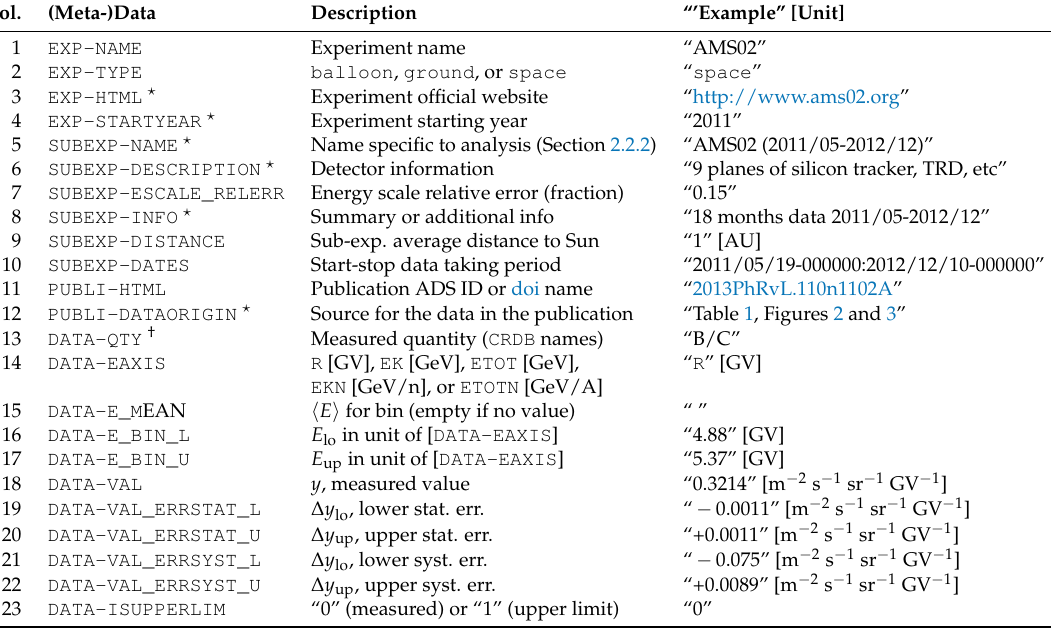
Table 2. Description of the 23 expected columns in the csv file prepared by the user to submit data. The table shows the column ID, the associated keyword in the database structure (see Figure 1), the expected content of the column, and an example (and associated unit) for this column—entries corresponding to starred keywords (cid:63) can be left empty (i.e., “ ”) if the user is unsure. For more details on CRDB data and meta-data definitions, see Section 2.1 (data points), Section 2.2.1 (experiments), Section 2.2.2 (sub-experiments), and Section 2.3.1 (publications).